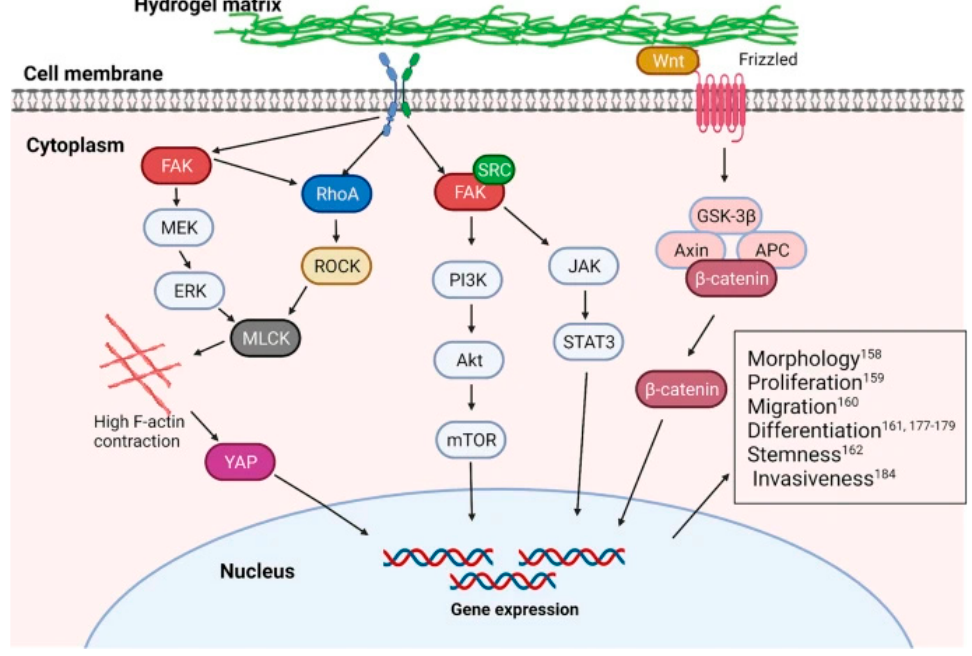
Figure 6. Pathways are involved in the regulation of cellular behavior by hydrogel stiffness. Reprinted with permission from [200] , Copyright 2021, Springer nature.